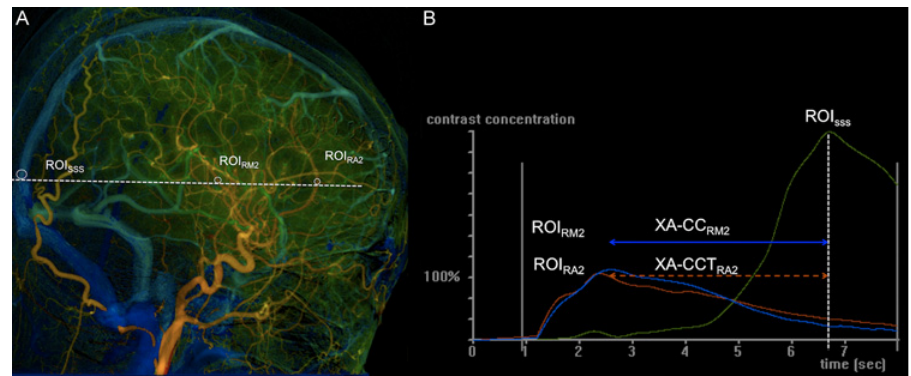
Fig 1. Lateral view of quantitative color-coded right common carotid DSA and the time density curves of ROIs. (A) Lateral view of quantitative color-coded right common carotid DSA. ROI RA2 was located at the greatest curvature of ACA. ROI SSS and ROI RM2 were chosen by drawing an imaginary line (dashed line) parallel to the osteomeatal line to intersect SSS and the insular branch of the right-middle cerebral artery (RM2) respectively. (B) Time density curves of ROI RA2 , ROI RM2 , and ROI SSS . The dashed line intersecting the X-axis perpendicularly indicate the Tmax of ROI SSS . The XA-CCT RA2 (double-headed line) was defined as the time difference between the Tmax of ROI RA2 and that of ROI SSS; the XA-CCT RM2 (dashed double headed line) was defined as the time difference between the Tmax of ROI RM2 and that of ROI